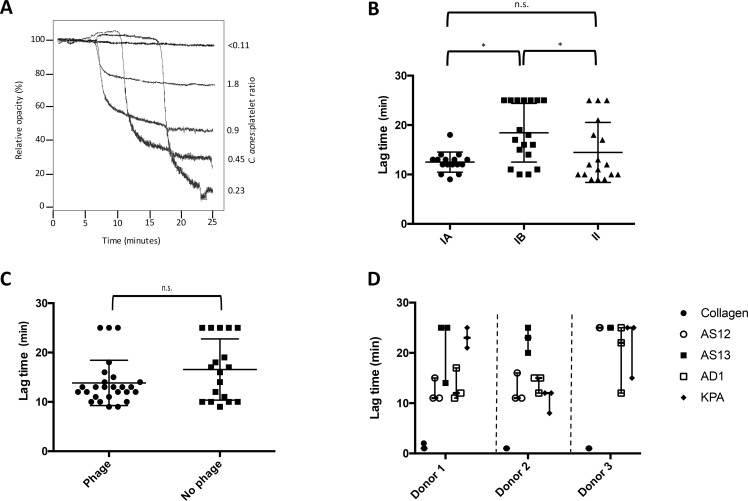
C. acnes aggregation of platelets is dose, type and donor-dependent.C. acnes isolate AS12 was incubated with platelets at different ratios (0.11:1–1.8:1; C. acnes:platelet) in plasma and aggregation measured using an aggregometer (Chronolog) (A). The ability of different types of C. acnes (B), presence of bacteriophages (C), or donors (D), to influence aggregation was investigated. Failure to induce aggregation is indicated by the maximum lag time (t = 25 min). Each dot in the figures represents one experiment (e.g. one bacterial strain). For phylotype and phage dependence, a single donor was used. All experiments were performed three independent times and are presented as medians with range where appropriate. Due to the non-parametric nature of the samples, Kruskal-Wallis (B, D), and Mann-Whitney (C) were used for statistical evaluation.